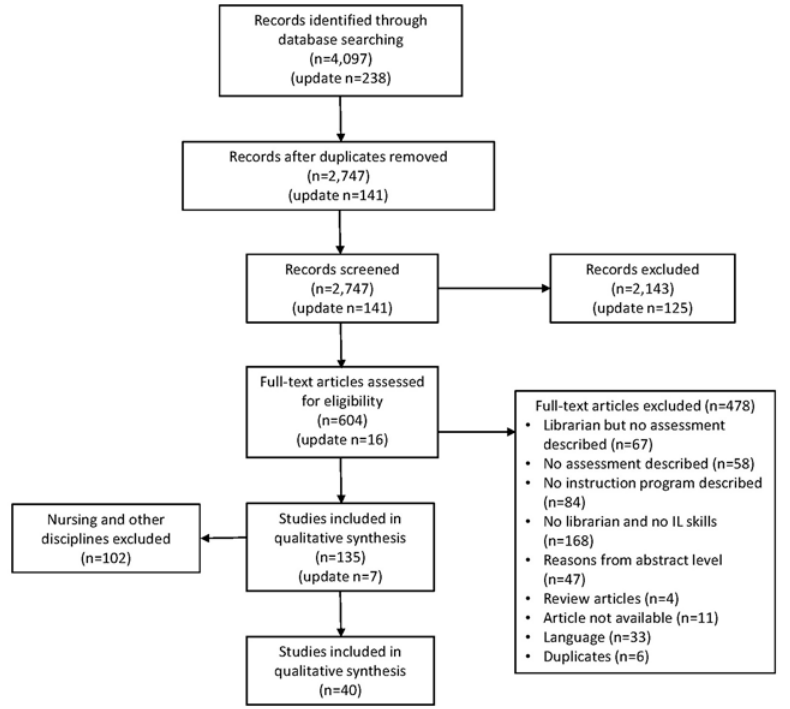
Figure 1 PRISMA flow